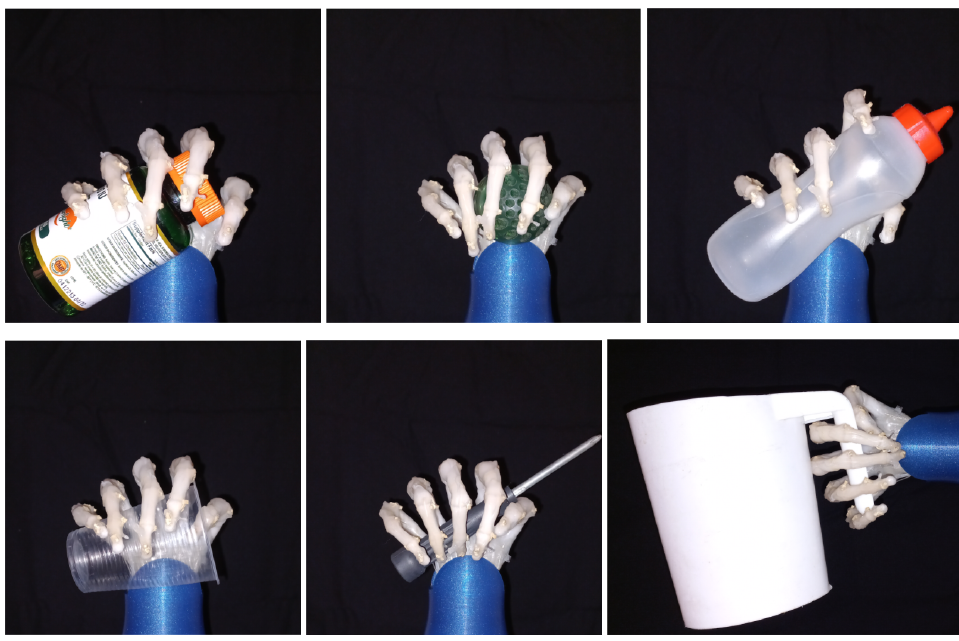
Figure 11. Power grip of different objects.